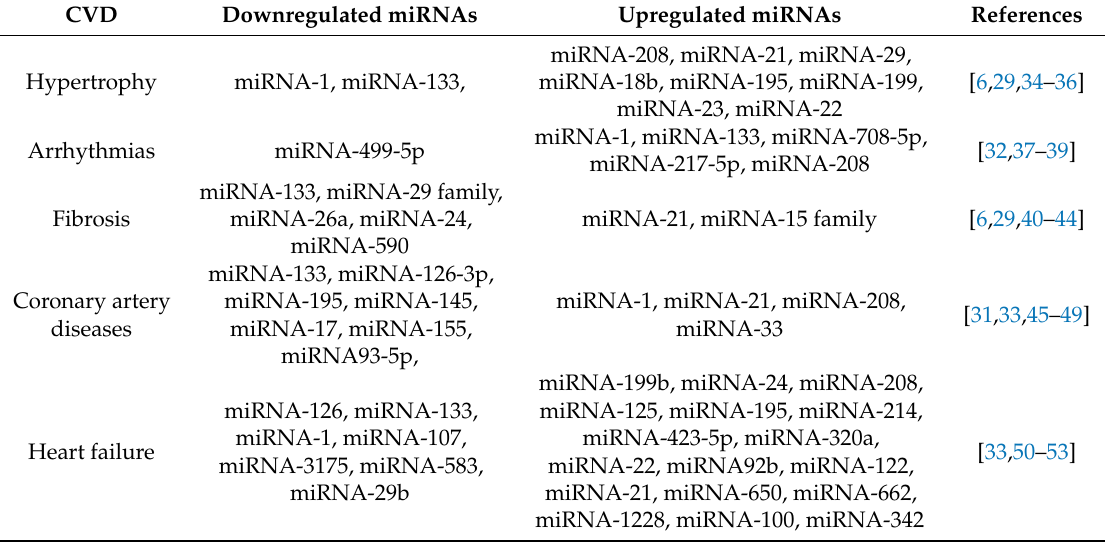
Table 1. Summary of miRNAs dysregulated in di ff erent cardiovascular diseases (CVD).